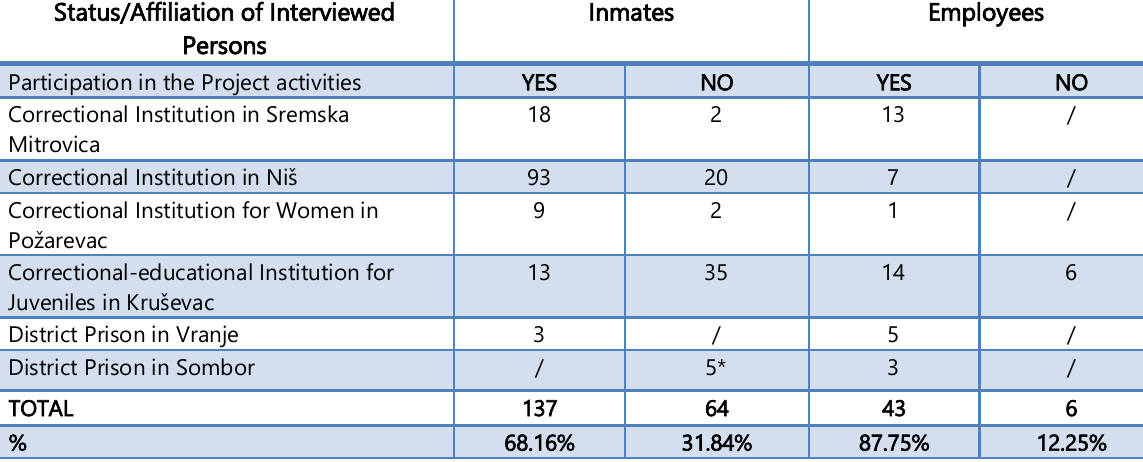
Table 7: Participation of the Interviewed Persons in the Project Activities (Source: Author‟s depiction) Status/Affiliation of